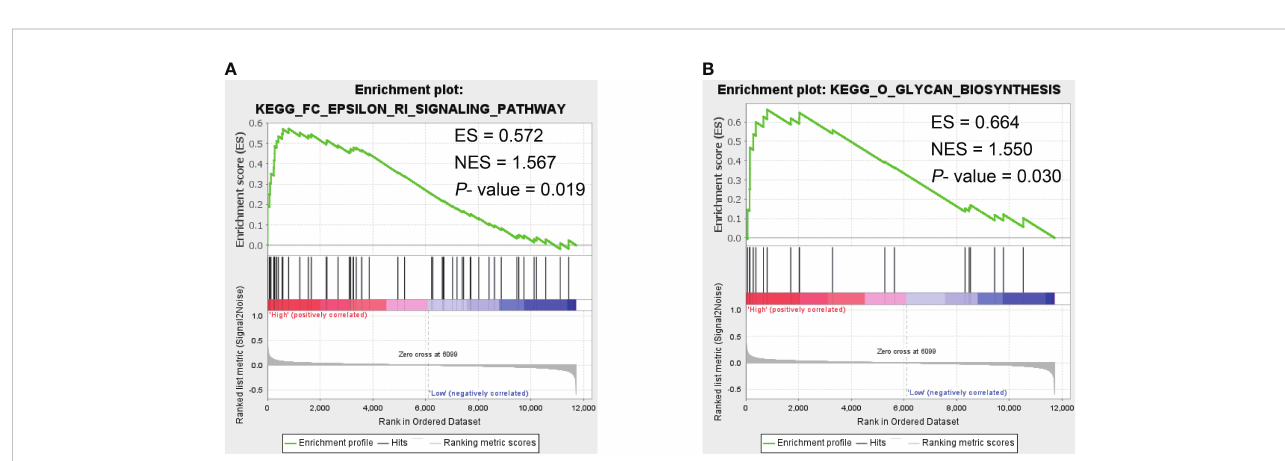
FIGURE 8 The GSEA result of CST1. (A) Fc epsilon RI signaling pathway. (B) O-glycan biosynthesis. ES, Enrichment Score; NES, Normalized Enrichment